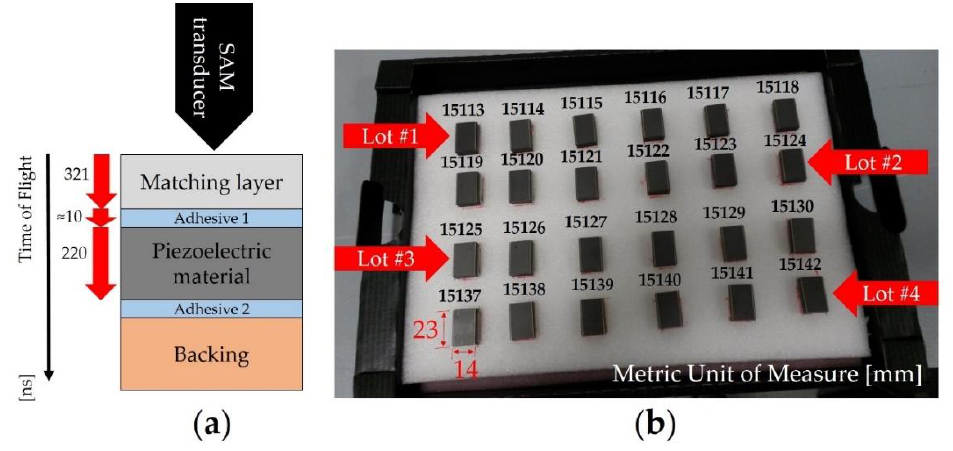
Figure 6. Samples selected for the SAM measurement campaign: ( a ) cross section of the samples under testing (not to scale) with the time of flights of the detected layers; ( b ) 24 acoustic stacks for ultrasonic transducer divided into 4 lots.